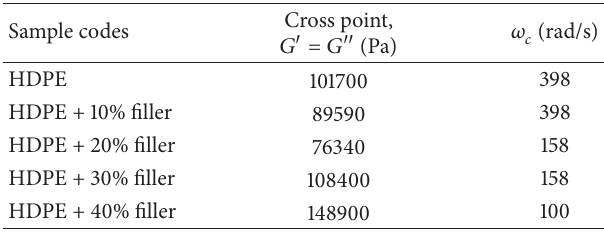
Table 1: Modulus and frequency values in the cross point 𝐺 󸀠 / 𝐺 󸀠󸀠 for the compositions analyzed.